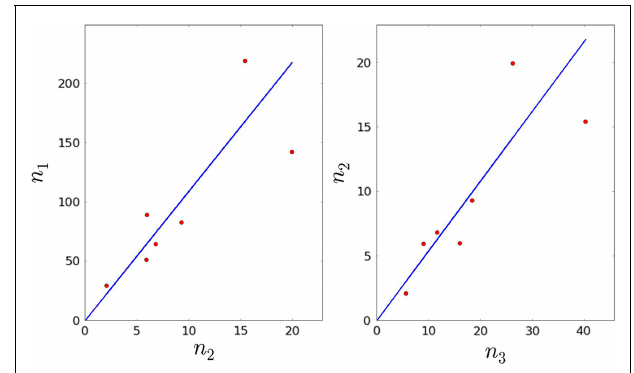
FIGURE 3 | Linear regression plots for the first model